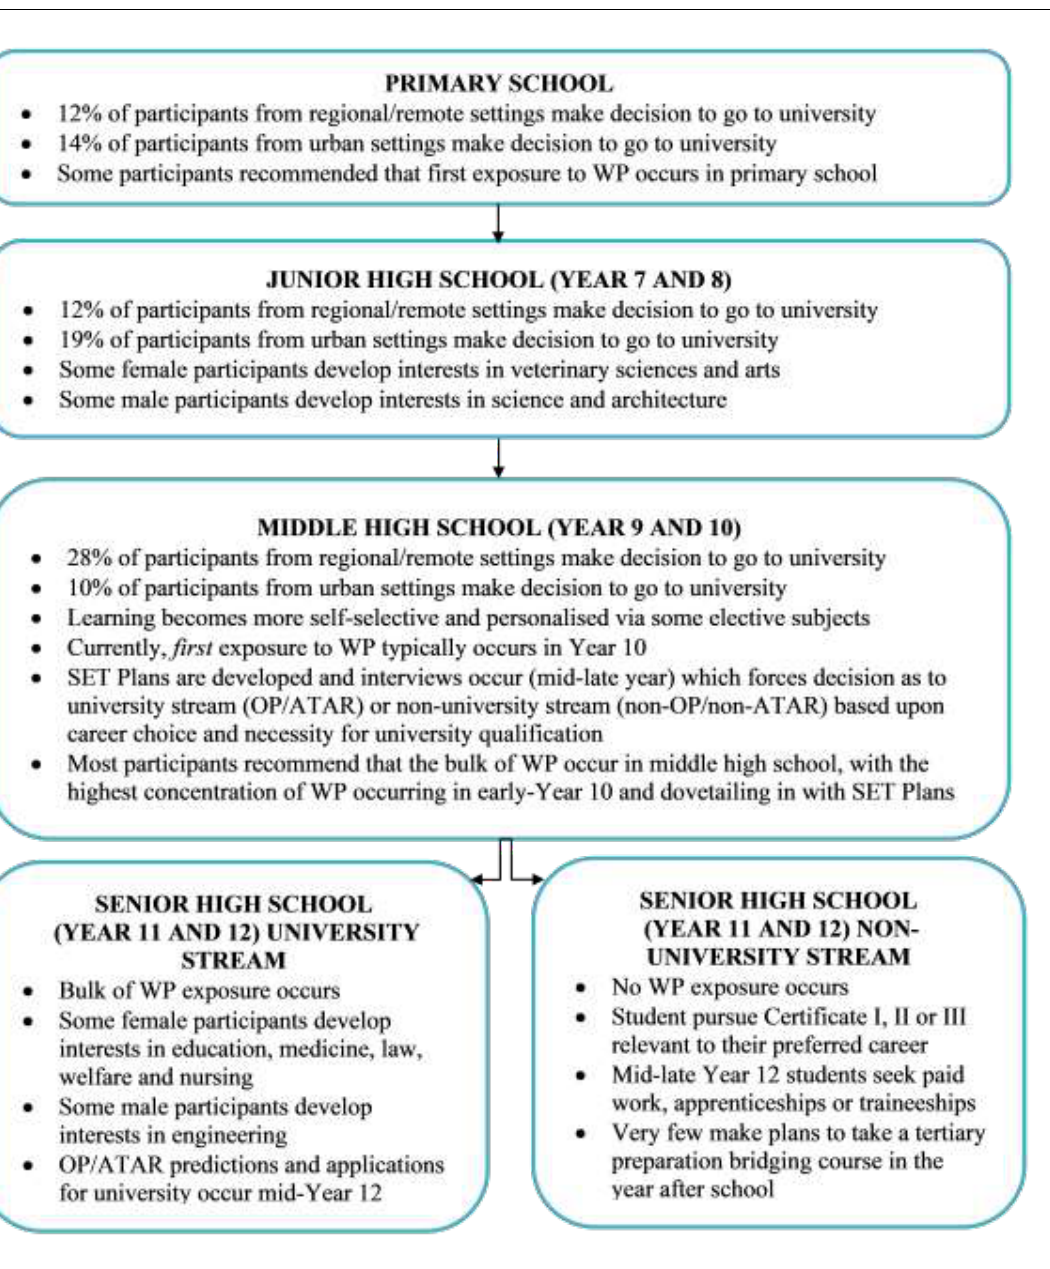
Figure 2. Participants journey map based on